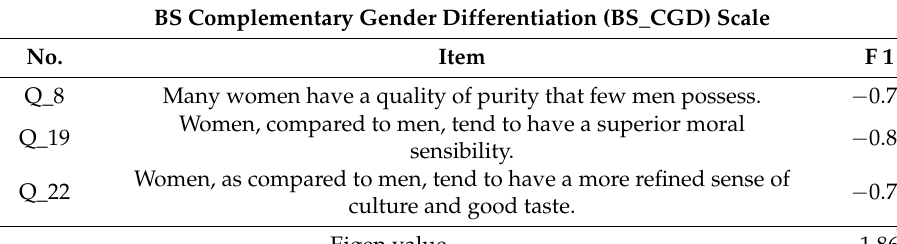
Table 3. Structural and metric characteristics of the two Benevolent Sexism ( BS ) scales.